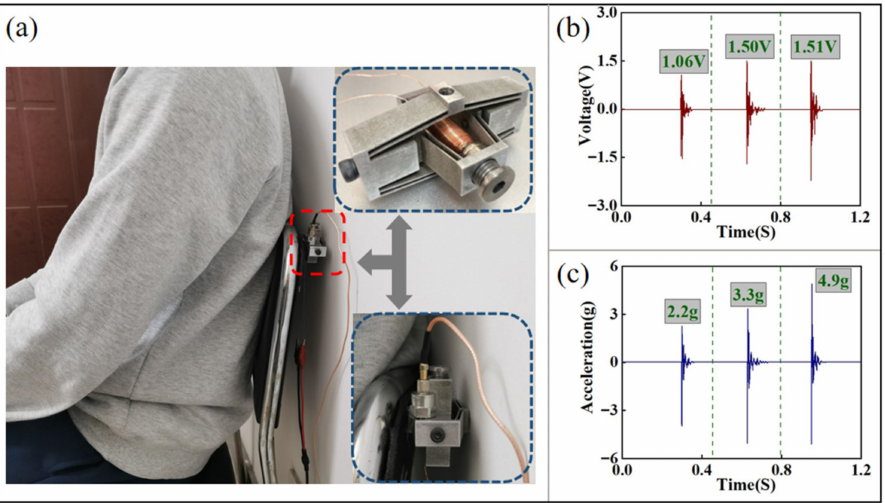
Figure 23. Experimental setup and output characteristics for practical applications. ( a ) Experimental setup and partial enlargement; ( b ) Output voltage; ( c ) Vibration